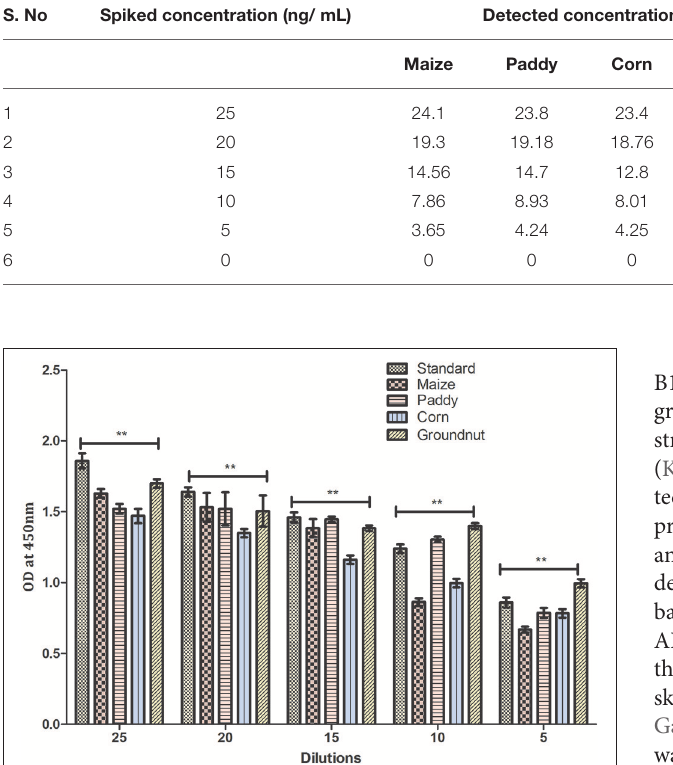
FIGURE 7 | Matrix interference of developed hybrid sandwich immunoassay. The matrix inference assay of various field samples spiked with AFB1 toxin (25–5 ng). Asterisks indicate a comparison between standard, maize, paddy, corn and groundnut samples, ** p < 0.01 of independent experiments performed and statistically evaluated using